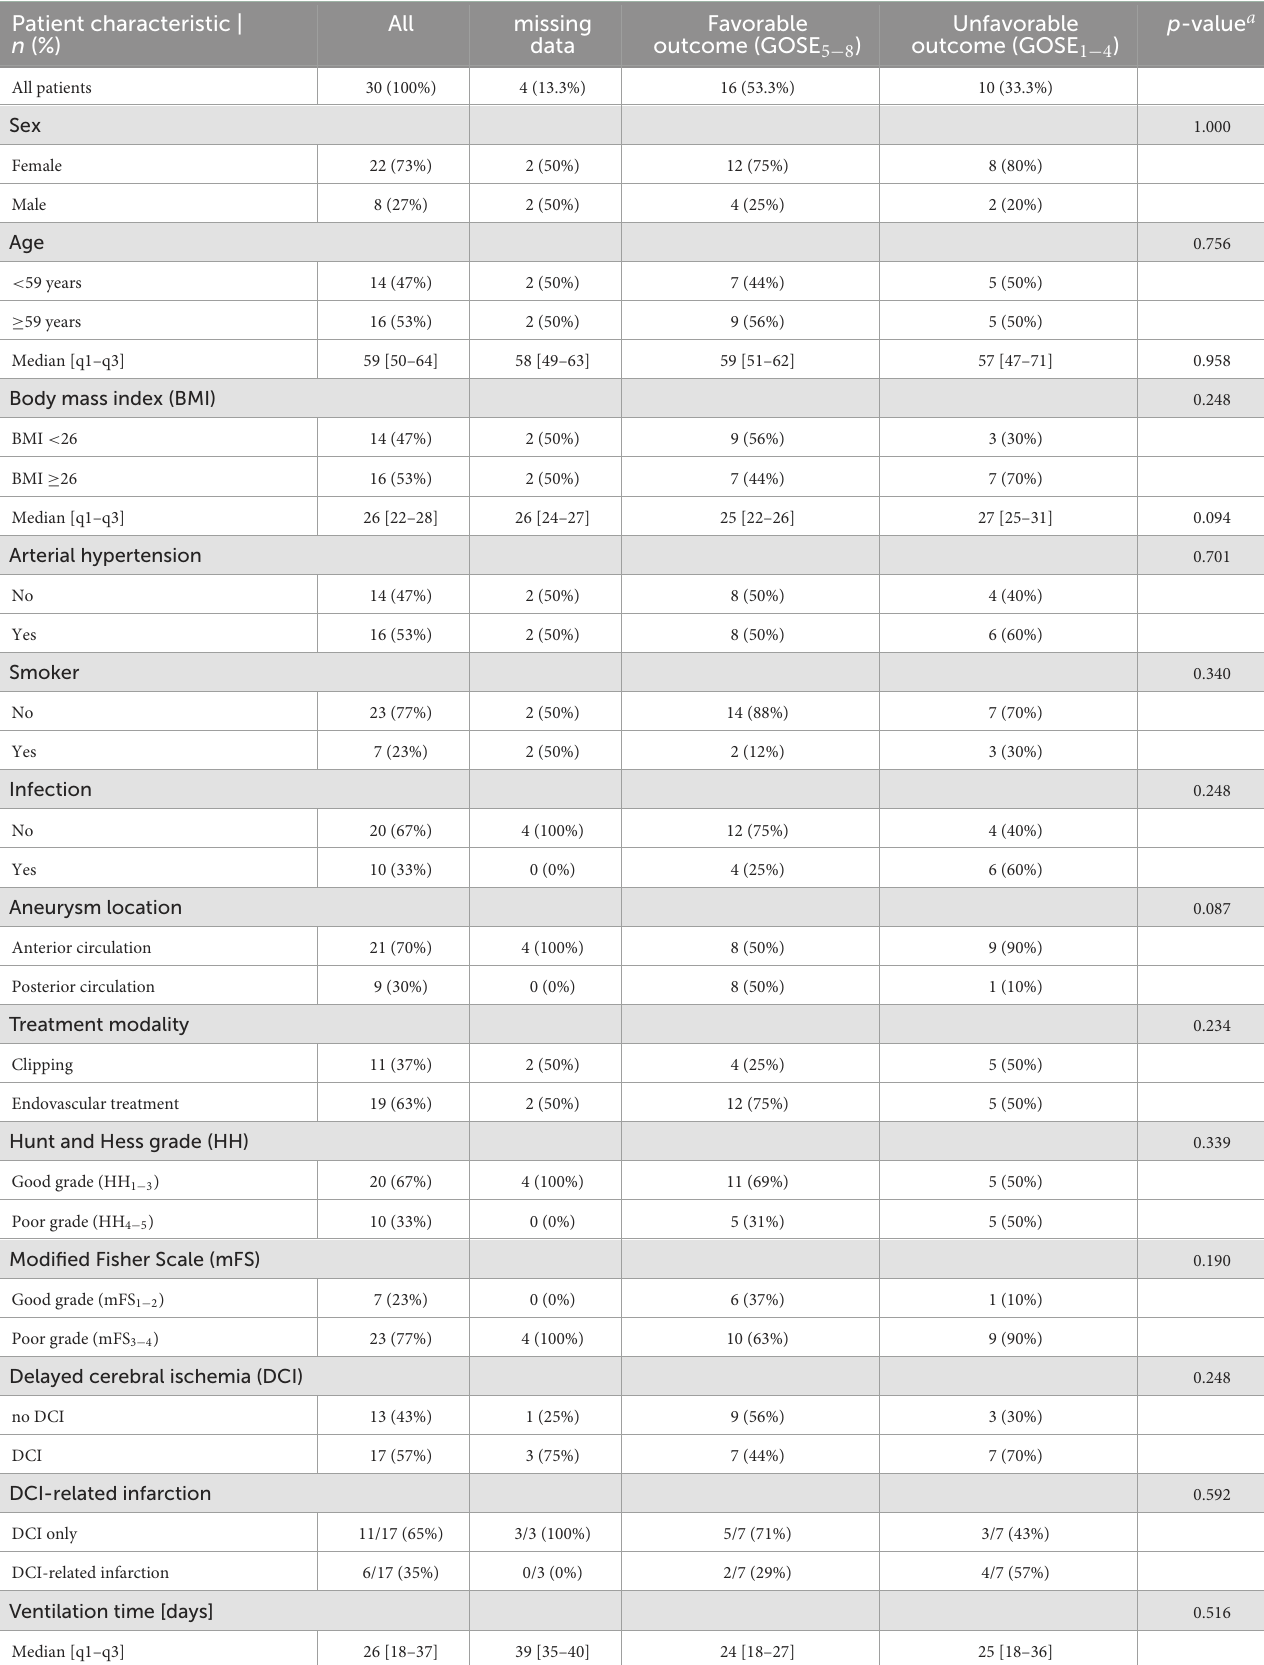
TABLE 1 Patient characteristics and their relation to clinical outcome after 12